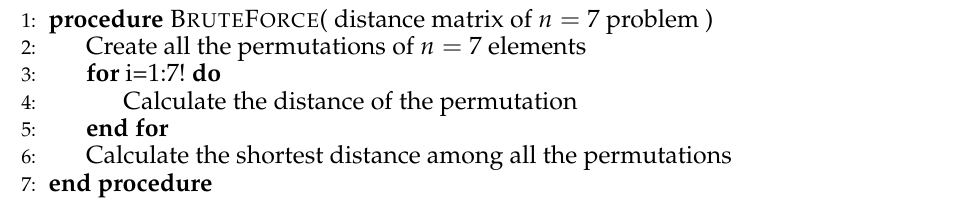
Algorithm 1 Algorithm to determine solutions using brute